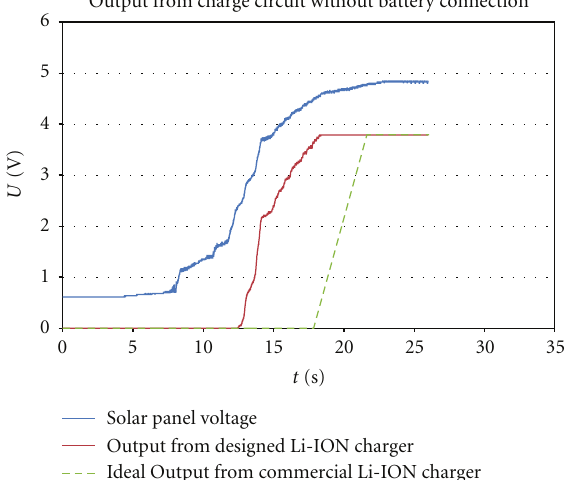
Figure 7: Process of voltage on solar panel, designed charging circuit, and ideal commercial solution.